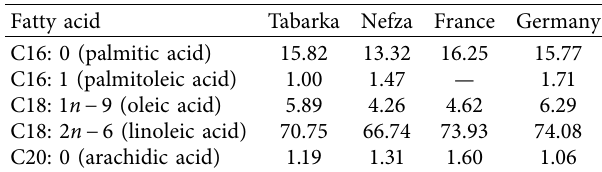
Means in each column followed by the same letters are not significantly different ( P > 0 . Table 7. There was significant variation in free radical scavenging activities among populations, and the inhibitory concentrations IC50 ranged from 123,29 to 541,81 mg/mL